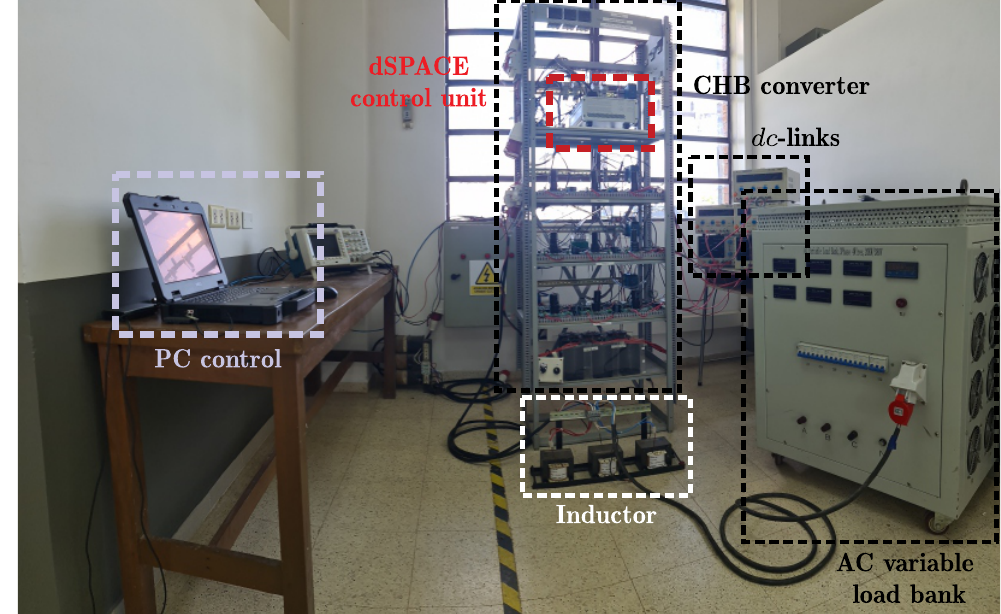
Figure 6. Experimental test equipment.